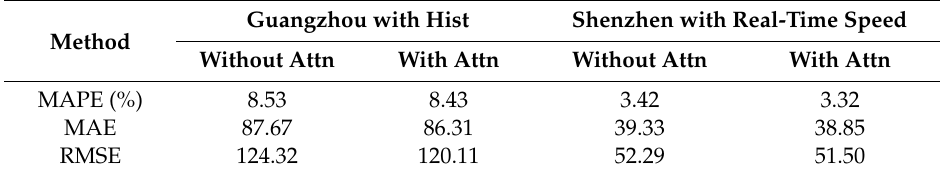
Table 8. Influence of the attention mechanism on the prediction results for Guangzhou and